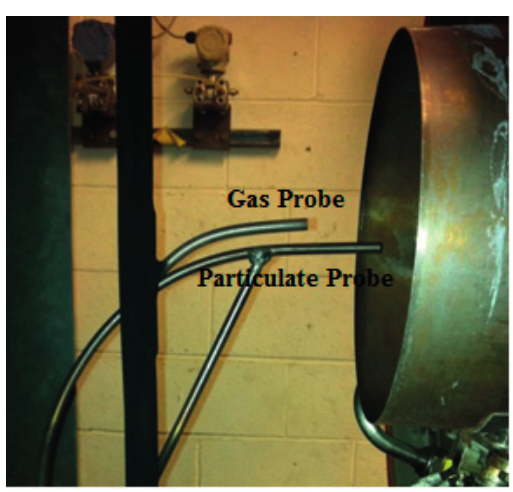
Figure 3. Sampling